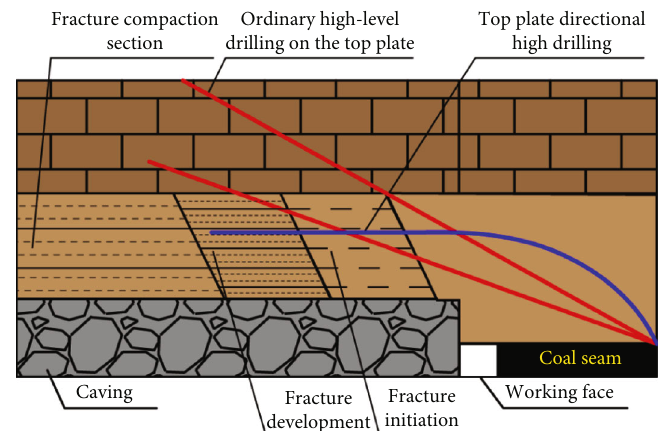
Figure 1: Schematic diagram of the development and evolution law of high-level borehole extraction and fracture zone in the roof.